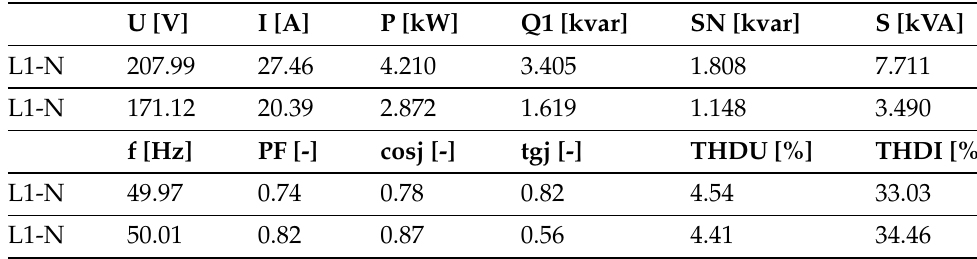
Table 2. Exemplary measurement results of electrical parameters (phase 1 circuit) for two values of power supply voltages of the fittings: 208 V and 171